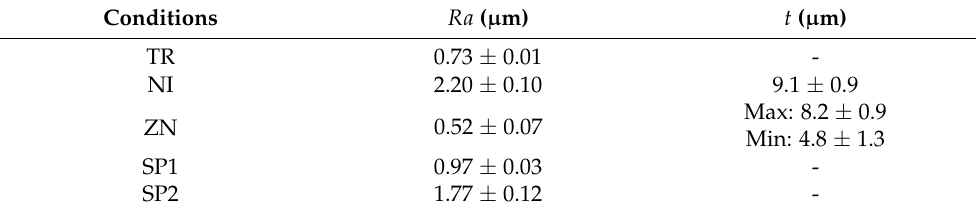
Figure 3. Tridimensional topography reconstruction of the investigated disks: ( a ) TR, ( b ) NI, ( c ) ZN, ( d ) SP1, and ( e ) SP2. Table 3. Roughness values ( Ra ) of the disks and thickness values ( t ) of the galvanizing